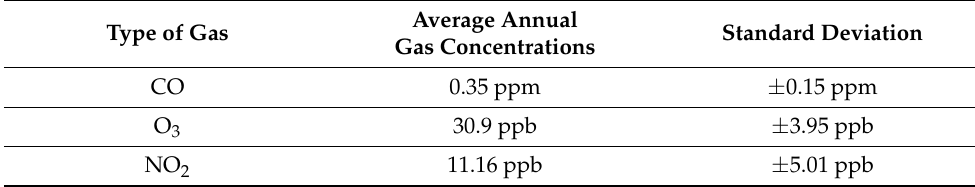
Table 3. Average annual concentrations of CO, O 3 and NO 2 in Taiwan in 2020